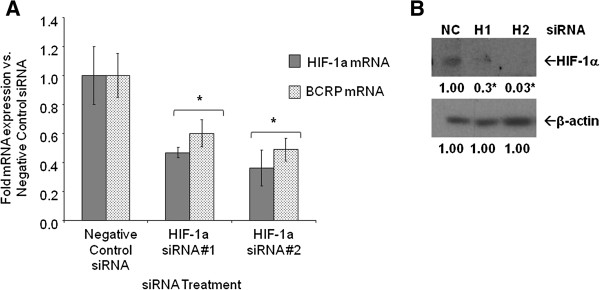
Effect of HIF-1α siRNA on mRNA expression in LTLTCa cells. A) LTLTCa cells were plated in passage media and then treated with two siRNAs for HIF-1α for 48 hours. Total mRNA was extracted and HIF-1α and BCRP mRNA, and 18S rRNA were analyzed by real-time RT-PCR. Real-time results are expressed as the mean fold-change in mRNA levels compared with negative control after normalization to 18S rRNA (mean ± SD, n = 6 independent samples/group; *versus negative control, P = 0.0057 for HIF-1α; P = 0.0026 for BCRP; one-way ANOVA). B) LTLTCa cells were plated in passage media and then treated with two siRNAs for HIF-1α for 48 hours. Total protein was extracted and HIF-1α and β-actin protein were analyzed by Western blot. Shown are representative blots and overall densitometry results of n = 6 independent cell samples/group. Densitometry results are expressed as mean fold-change in protein levels compared to negative control after normalization to β-actin (mean ± SD, n = 6 independent cell samples/group; *versus negative control (NC), P <0.0001, one-way ANOVA). ANOVA, analysis of variance; BCRP, breast cancer resistant protein; HIF-1α, hypoxia inducible factor 1 α subunit; n, number; SD, standard deviation.